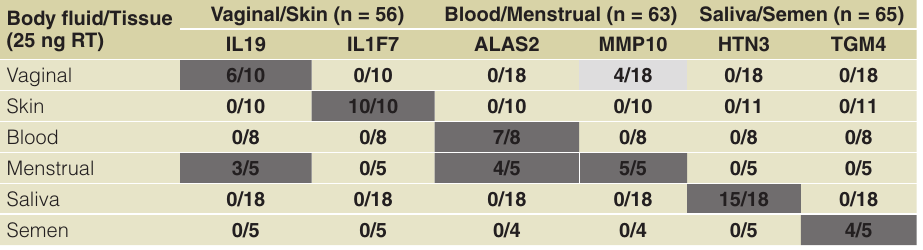
Table 2. HRM duplex assay specificity. The number of samples from individuals in which the marker was successfully detected is displayed (numerator) out of the total number of individuals tested (denominator). The shading reflects the number of positive samples out of the total number tested: white – no detection; light grey 1–59%; dark grey ≥ 60%.